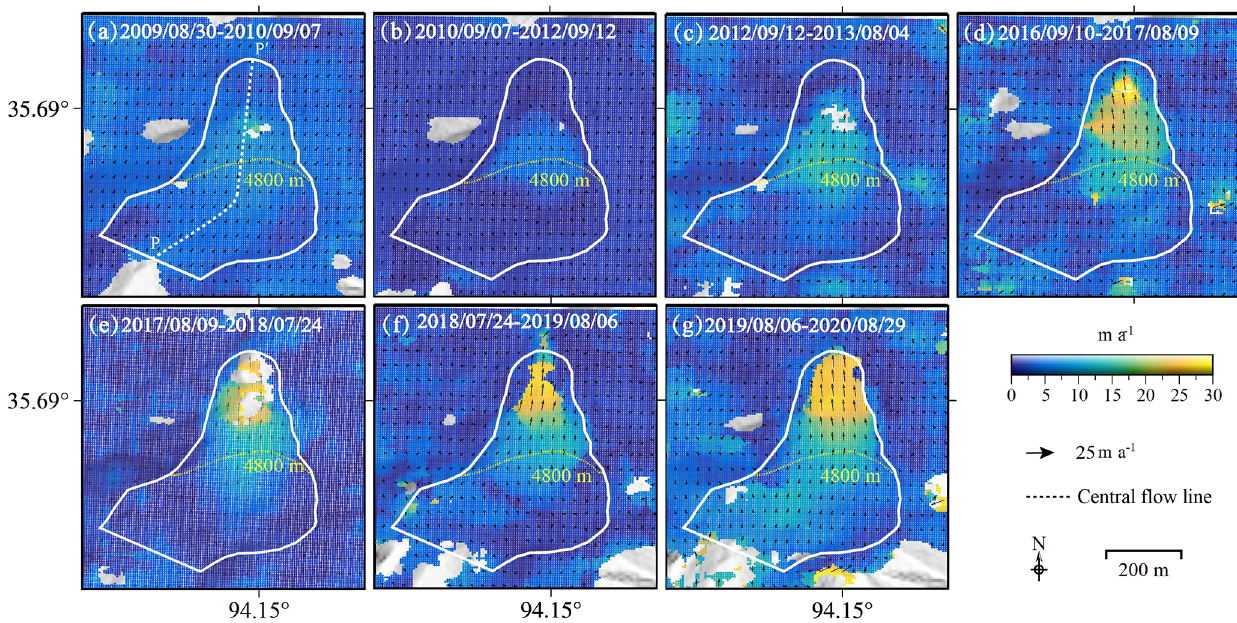
Figure 8. Surface velocities over the glacier tongue of KLP-37 from image cross-correlation based on the seven Planet image pairs. The profile PP (cid:48) represents the central flow line, and the arrows mark the flow direction.